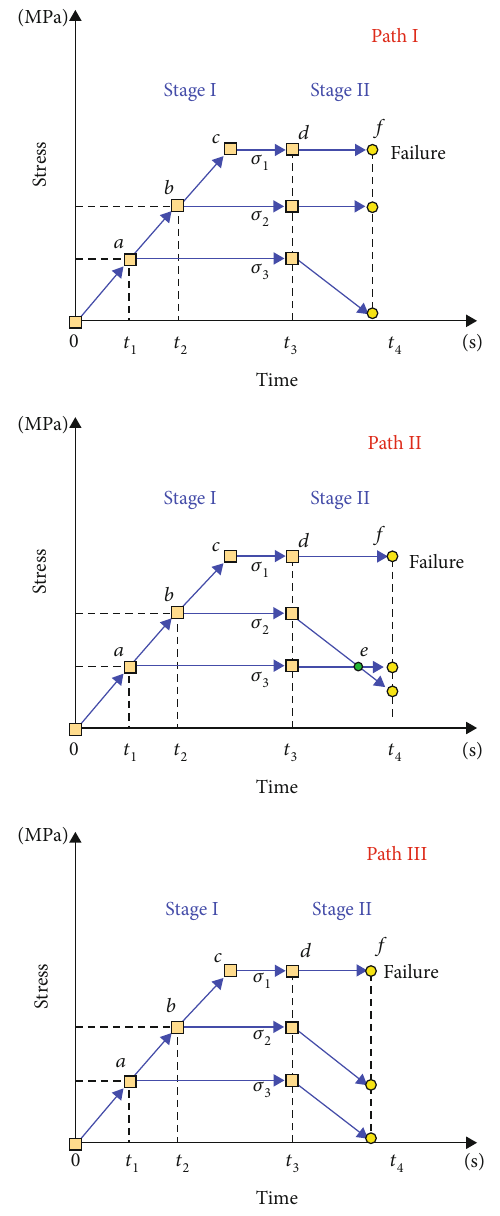
Figure 9: Typical loading and unloading